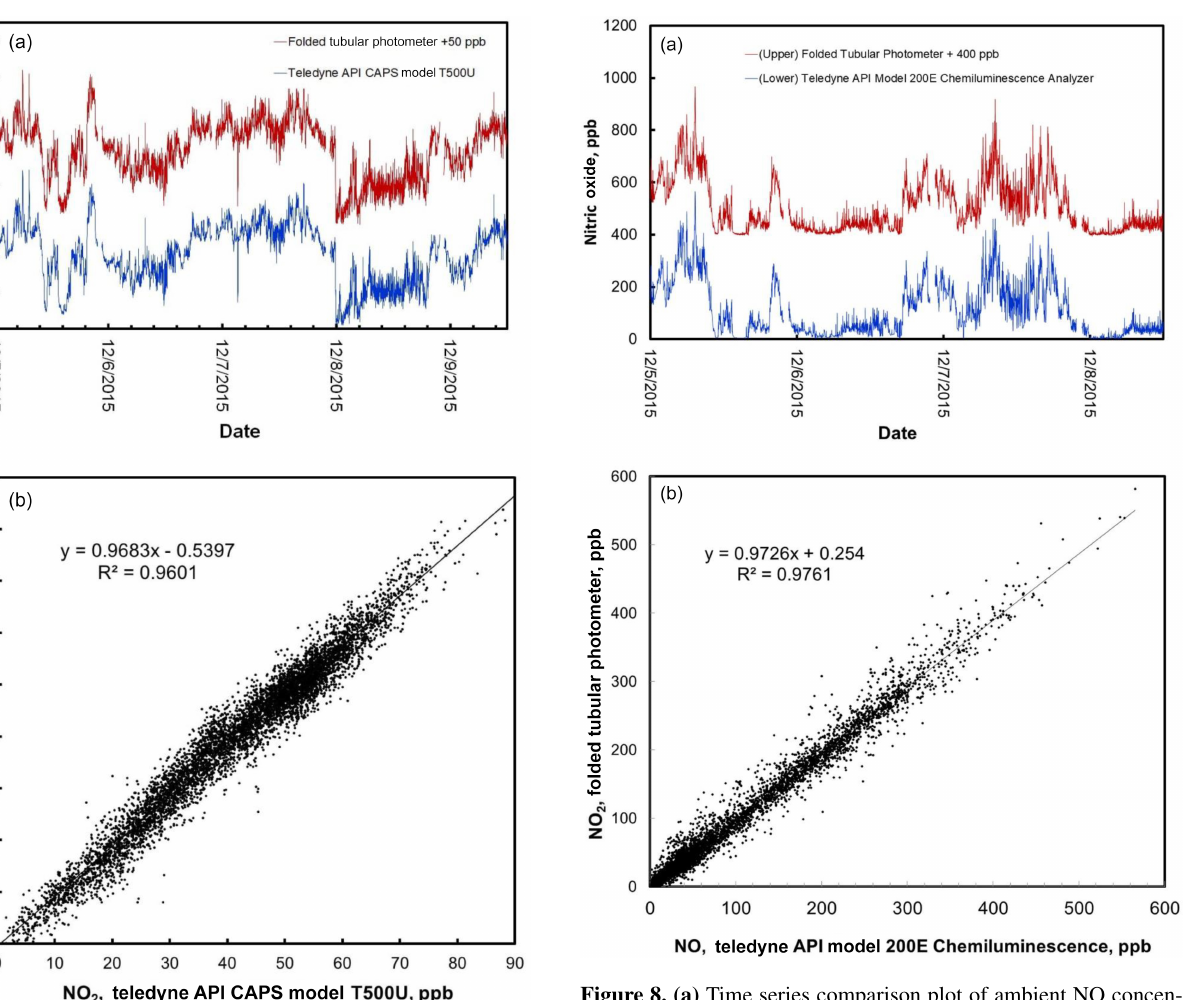
Figure 8. (a) Time series comparison plot of ambient NO concen- tration measured outdoors at the CDPHE Interstate 25/Globeville roadside site using a Teledyne API model 200E Chemilumines- cence Analyzer (lower data line) and a folded tubular photometer (upper data line). Data for the folded tubular photometer are offset for clarity by adding 400ppb to the measurements. (b) The same data, shown as a correlation plot. Data shown in the bottom panel include the small correction for N 2 O 5 formation as described in the